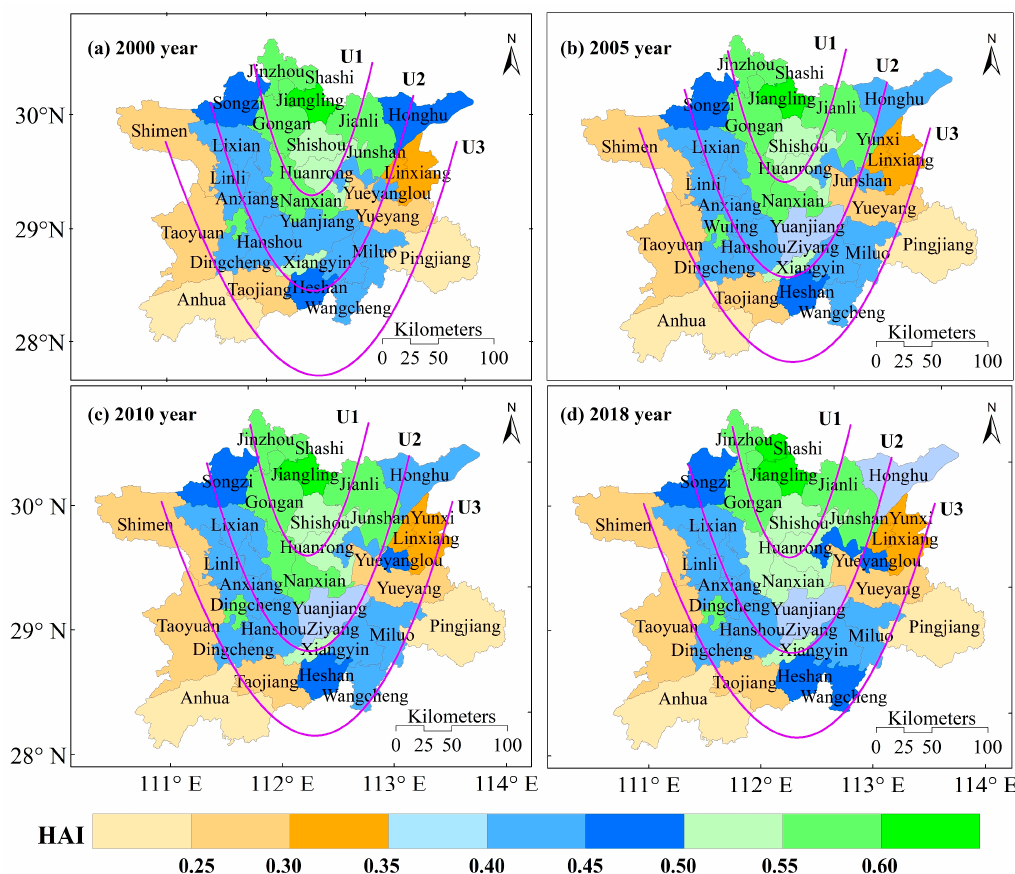
Figure 5. Spatial distribution of the HAI in Dongting Lake counties (cities and districts).